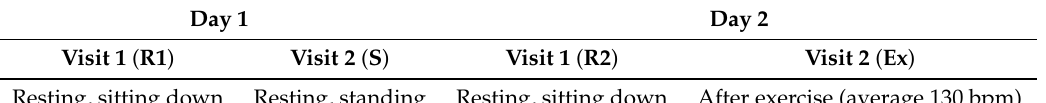
Table 2. Selected database visit distribution. The four visits are re-named as shown, based on the type of scenario: R1 and R2 for resting while sitting down, S for resting while standing up, and Ex for